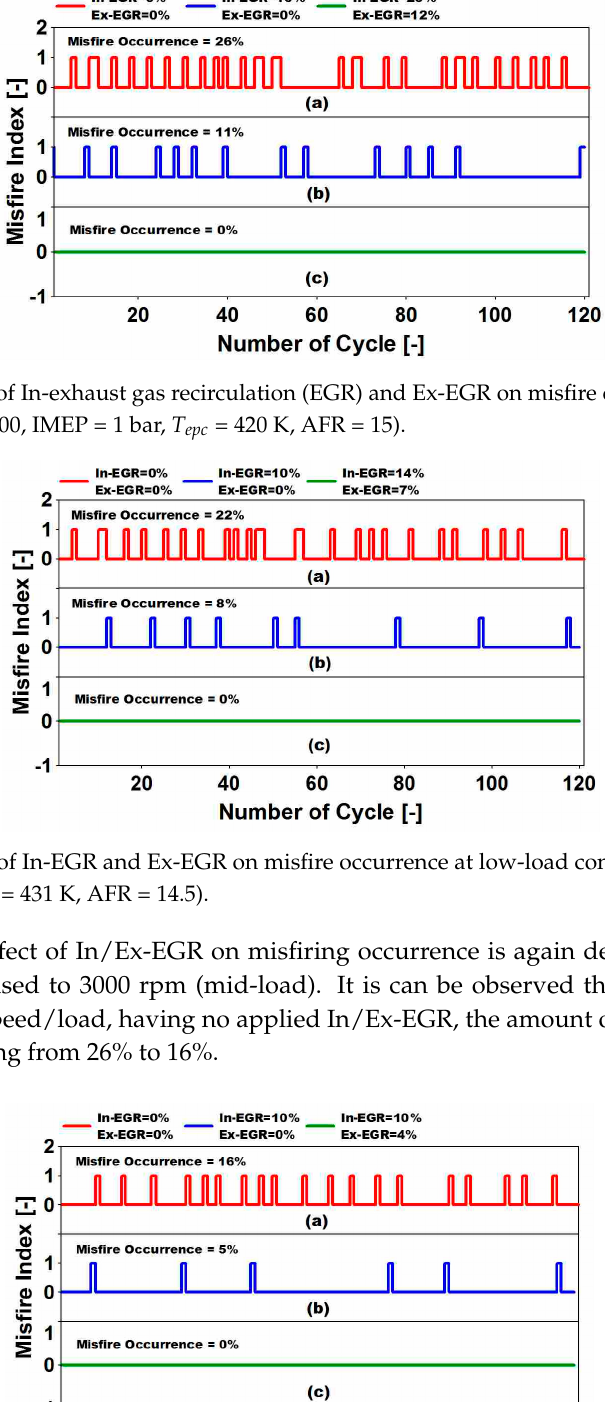
Figure 5. Influence of In-EGR and Ex-EGR on misfire occurrence at mid-load condition (rpm = 3000, IMEP = 2.1 bar, T epc = 451 K, AFR = IMEP = 2.1 bar, T epc = 451 K, AFR = 13.5).